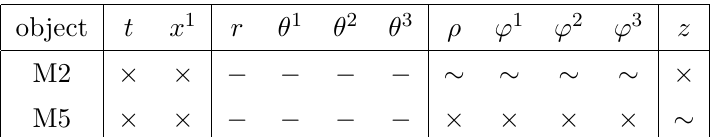
parametrized by ( r, θ i ) γ